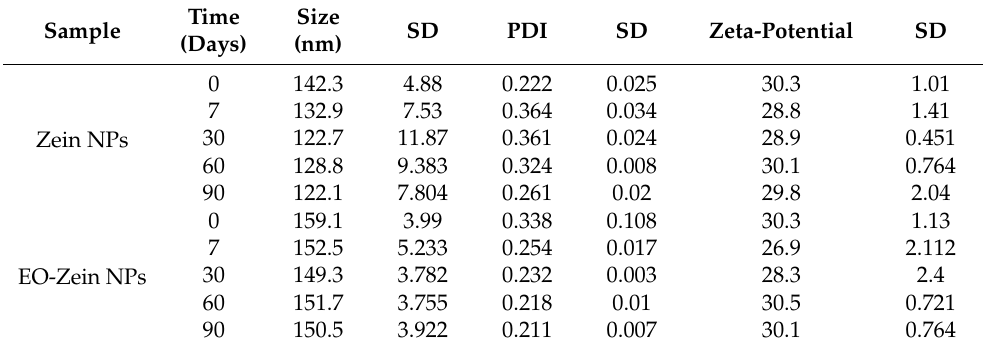
Table 2. Stability, surface charge and polydespersion index of EO-Zein NPs and empty zein NPs, assessed with the dinamic light scattering